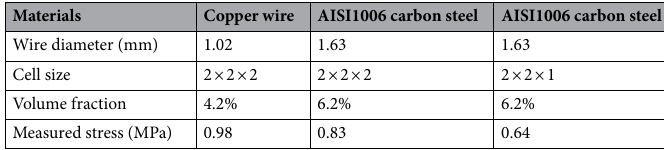
Table 1. Properties of lattice structure nodes joined with the epoxy polymer.